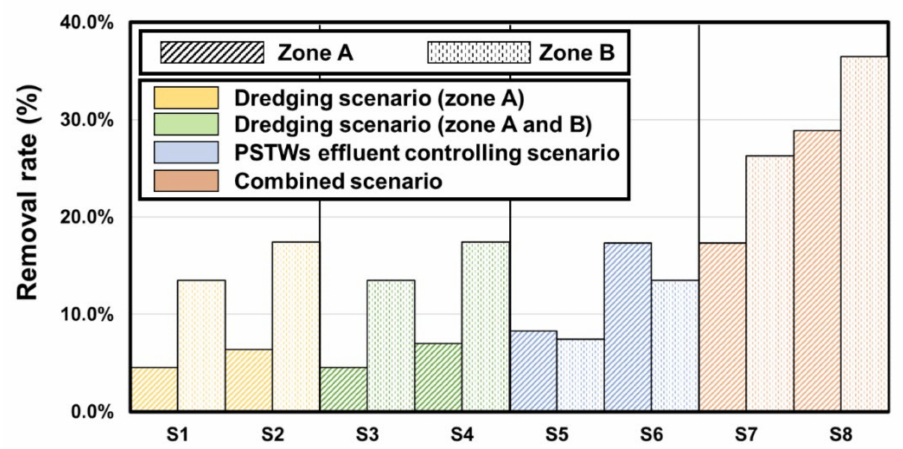
Figure 14. T-P removal rate results (Sn/S0, n = nth scenario).